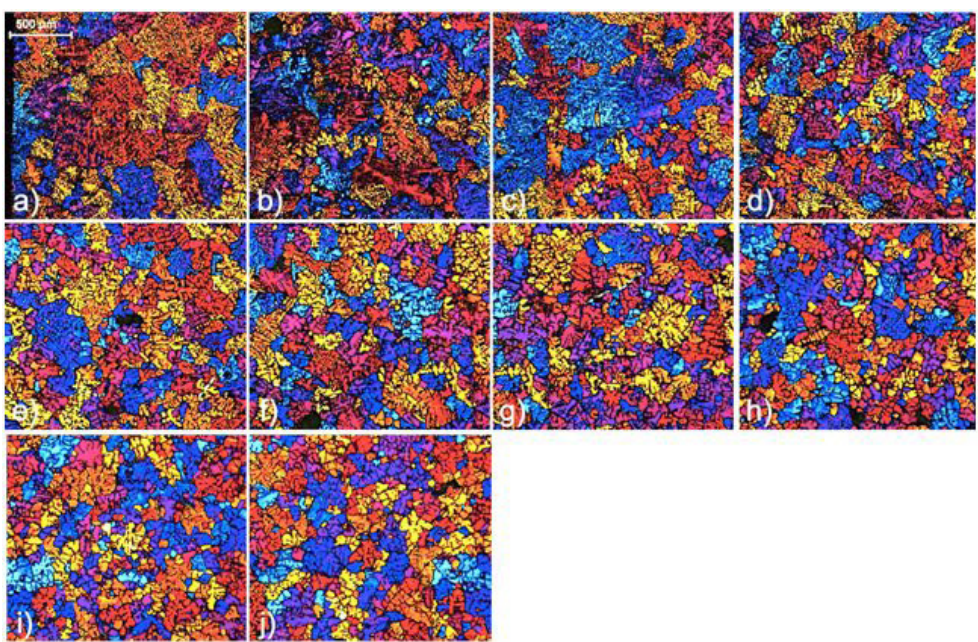
Figure 3. PL microstructure of longitudinal section 1 of the ingot at increasing distances from the extractor: (a) 2.5, (b) 5.0, (c) 7.5 , (d) 10.0, (e) 12.5, (f) 15.0, (g) 17.5, (h) 20.0, (i) 22.5 and (j) 25